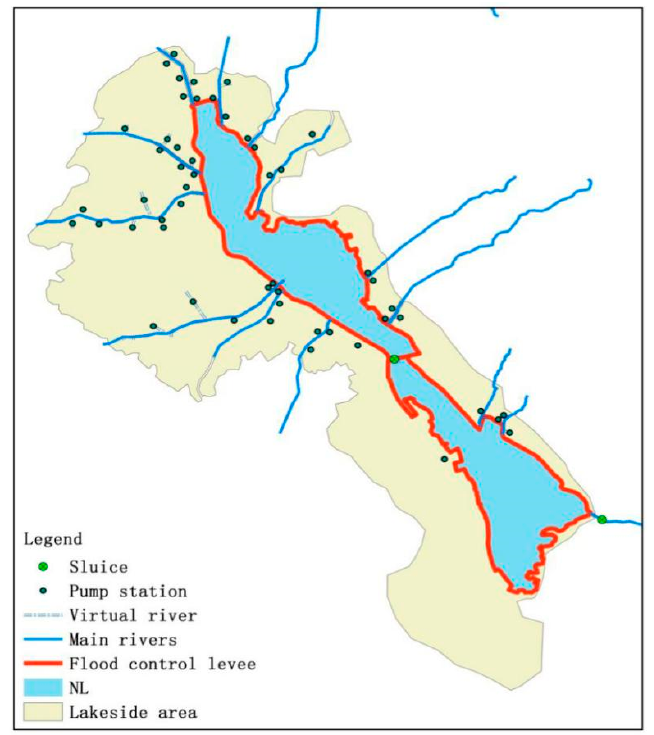
Figure 2. The structure of the Nansi Lake Flooding and Waterlogging Simulation Model.